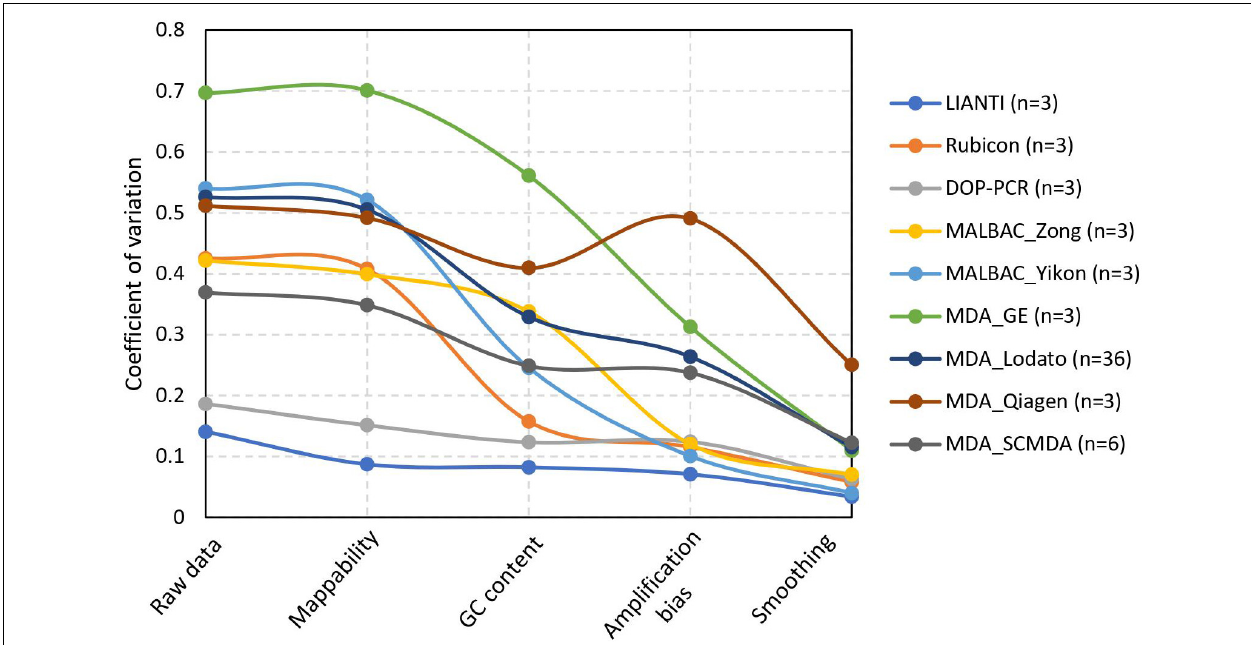
FIGURE 3 | Decreased coefficient of variation by normalization steps in SCCNV. Each line presents the average CV of normalized sequencing depths of multiple single cells amplified using the same experimental procedures. See Supplementary Table 1 for citations and SRA ids of each experimental